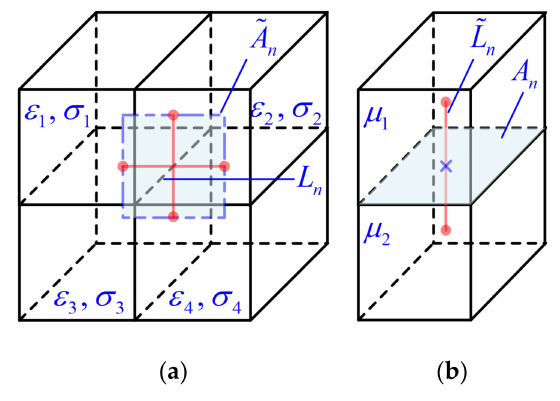
Figure 4. Construction of the material matrices. ( a ) The four cells involved in the average of permittivity and conductivity, ( b ) the two cells involved in the average of